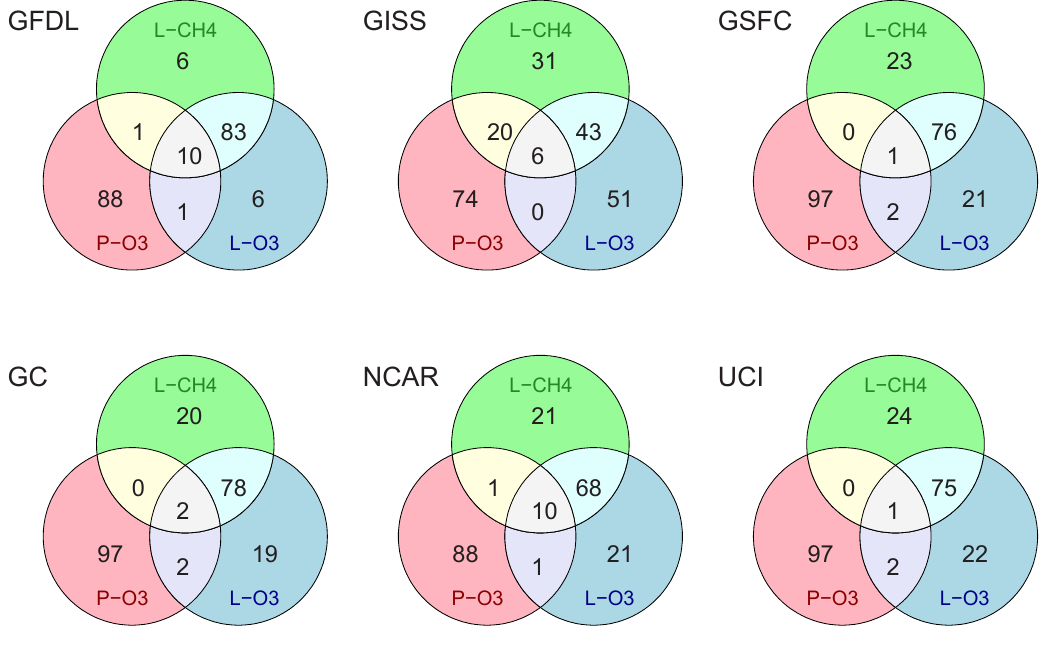
Figure 6. Venn diagrams for each model showing the overlap (%) of the top 10% parcels in each reactivity, using 5-day means for each